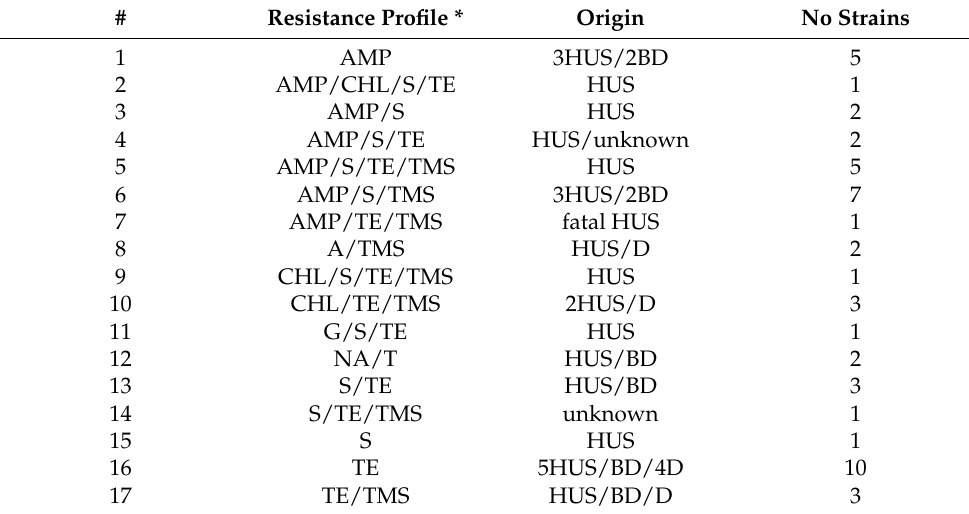
Table 1. Resistance profiles associated to the different clinical